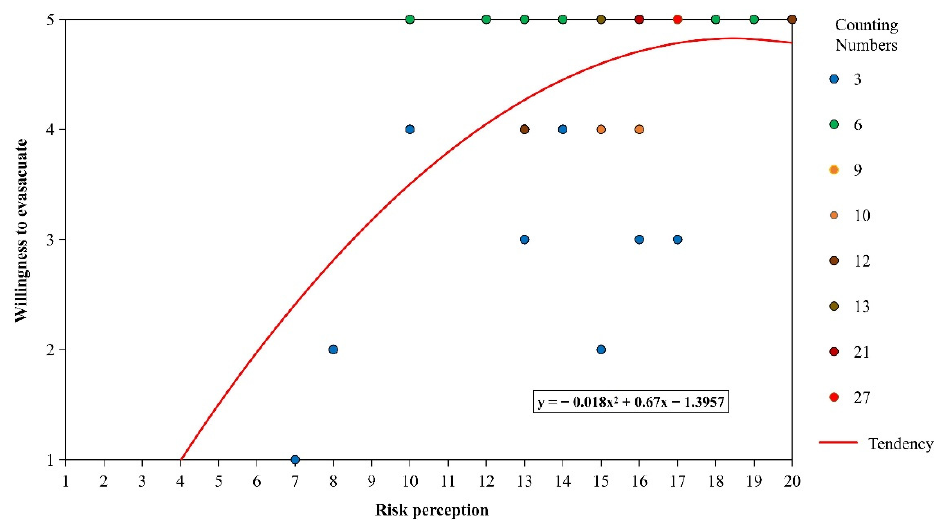
Figure 8. Correlation between risk perception and willingness to evacuate.